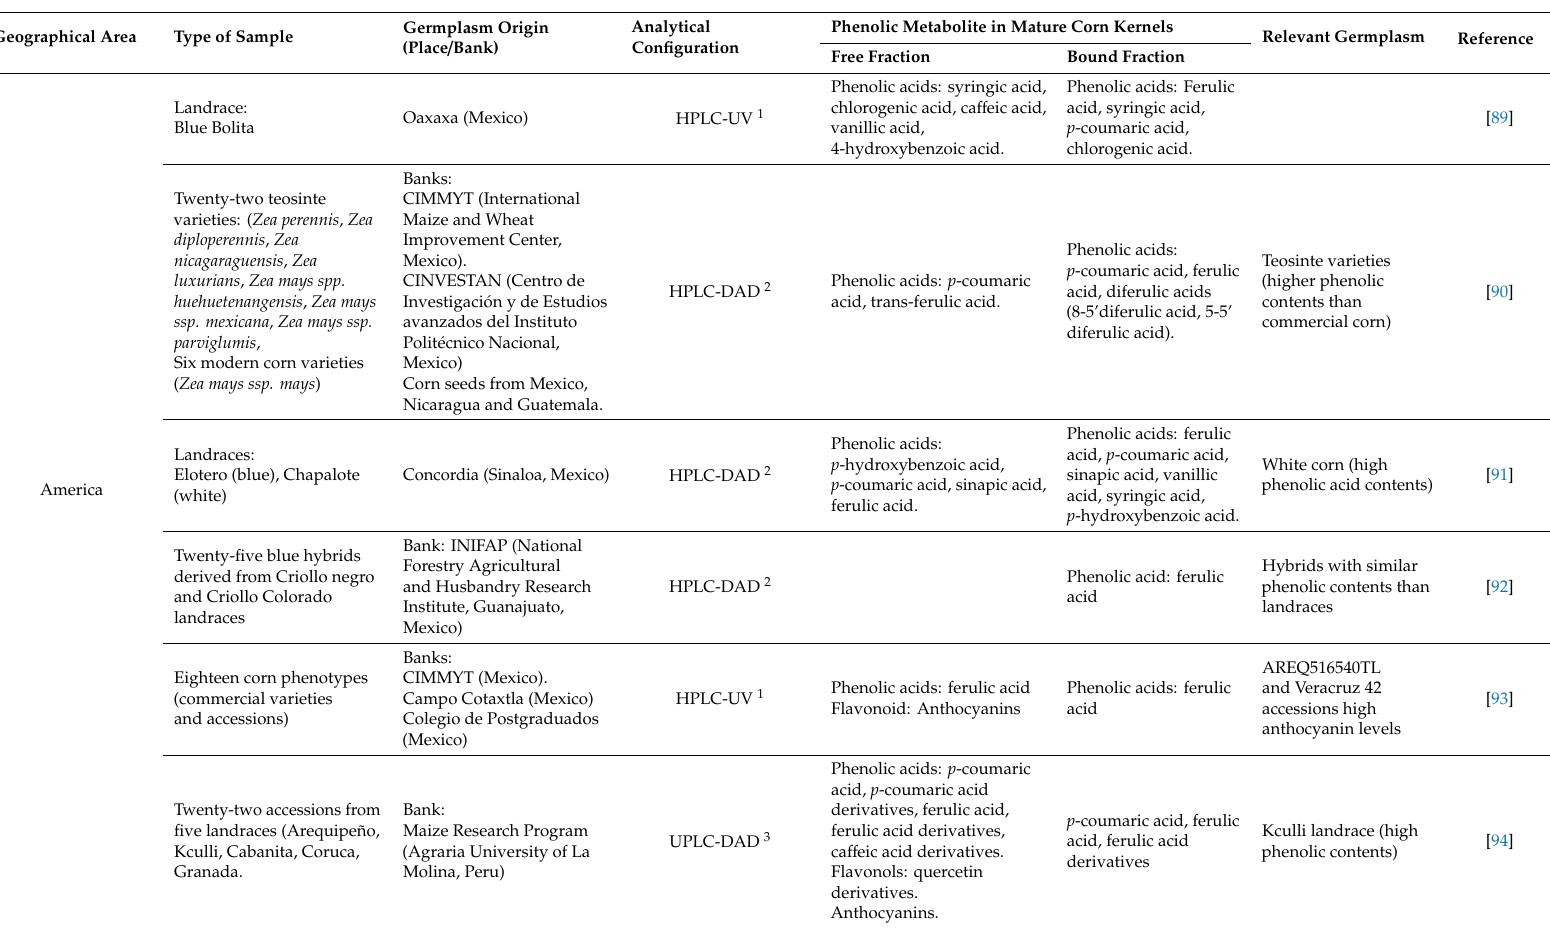
Table 3. Other targeted metabolomic platforms used for the characterization of phenolic bioactive compounds in worldwide corn biodiversity. Geographical